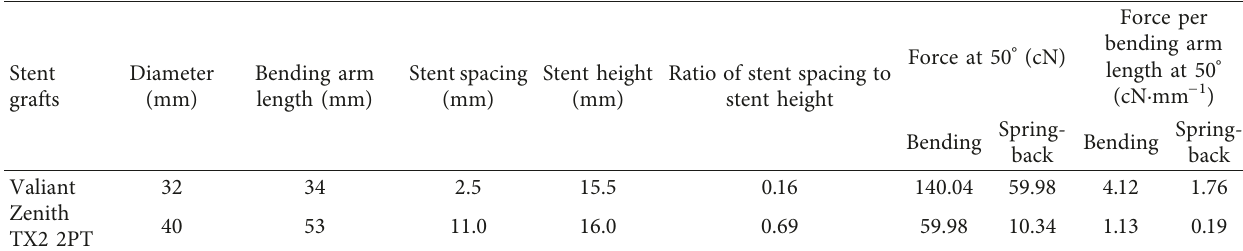
Table 6: Bending and spring-back forces of commercial stent